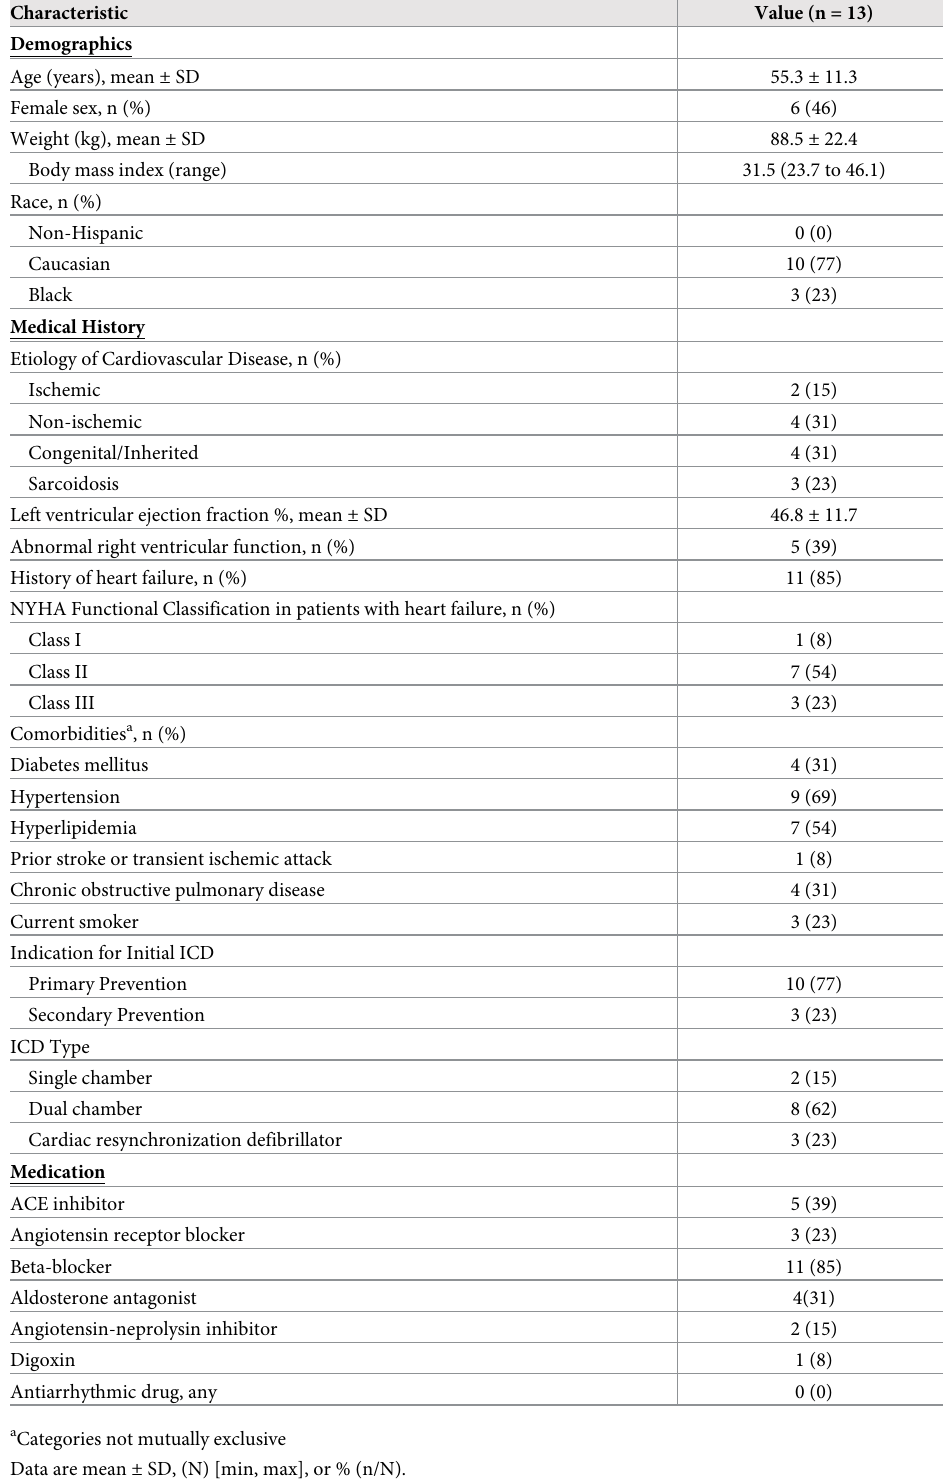
Table 5. Human study baseline